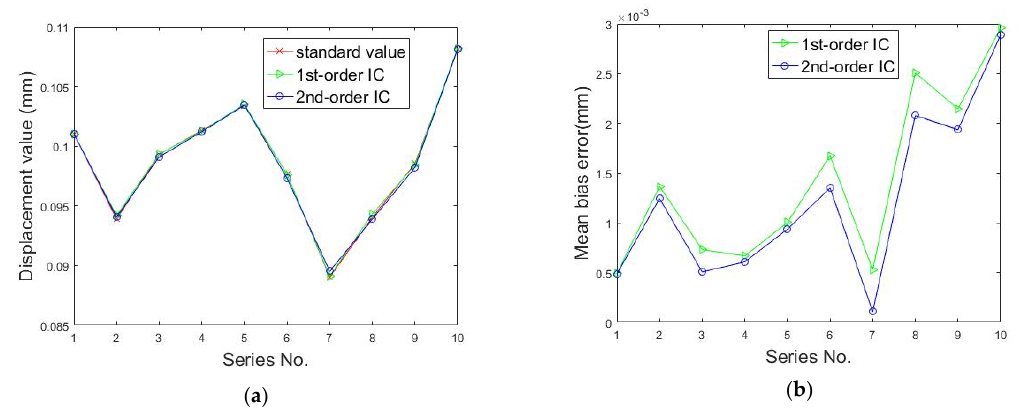
Figure 13. In-plane displacement measurement.